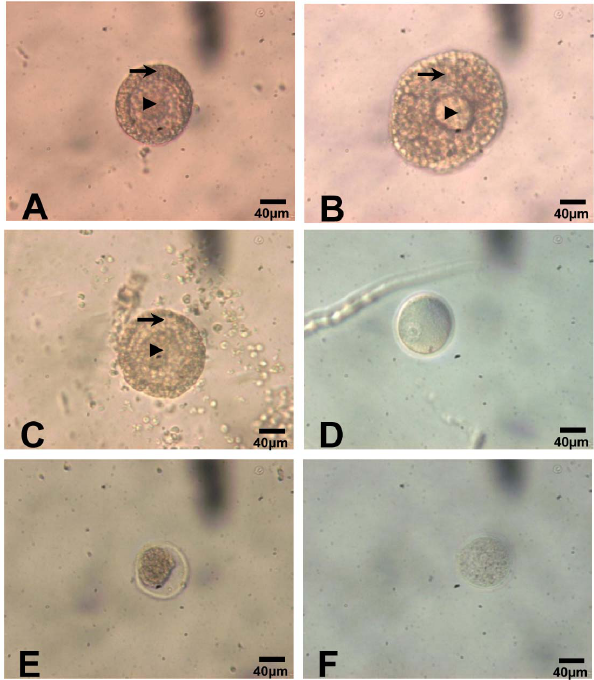
Figure 1. Representative examples of preantral follicle and oocyte in different phase. (A) Follicle isolated mechanically (day 0): central germinal vesicle (GV)-stage oocyte (arrow head) with a thin zona pellucida, surrounded by two layers of cuboidal granulosa cells (arrow), a basal membrane and a single layer of theca cells (original magnification 6 200). (B) Preantral follicle after 4 days of culture with FSH (10 ng/ml) had intact basal membrane with proliferated granulosa cells (original magnification 6 200). (C) Preantral follicle after 4 days of culture had shrunk with smaller oocyte (original magnification 6 200). (D) The follicle culture on day 4 was punctured and healthy oocyte was released. (E, F) The oocytes from those darken and or shrunk follicles showed retrogression with many particles or big gap between oocyte and zona pellucida (original magnification 6 200). Bars = 40 m m.